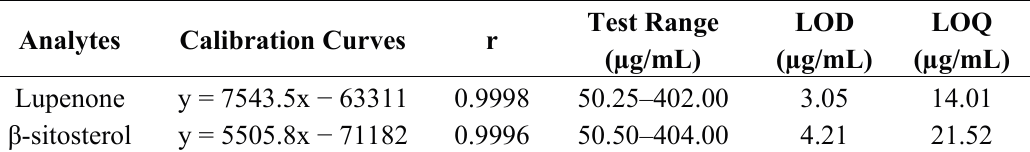
Table 2. Calibration curve values for lupenone and β -sitosterol.